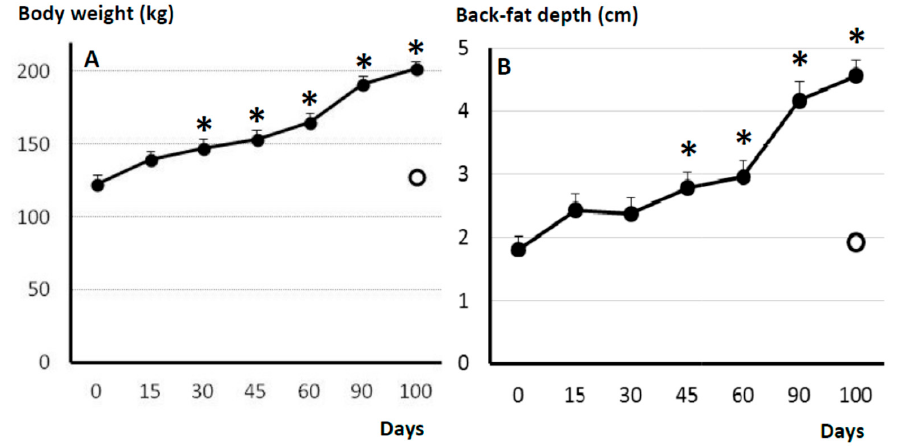
Figure 1. Mean ( ± S.E.M.) values in body-weight ( A ) and back-fat depth ( B ) in control sows (white dot; n = 17) and changes in such values over time after starting differential feeding with a diet enriched with saturated fat in treated sows (black line and dots; n = 11). Asterisks (*) denote significant differences between obese and non-obese sows ( p < 0.05).